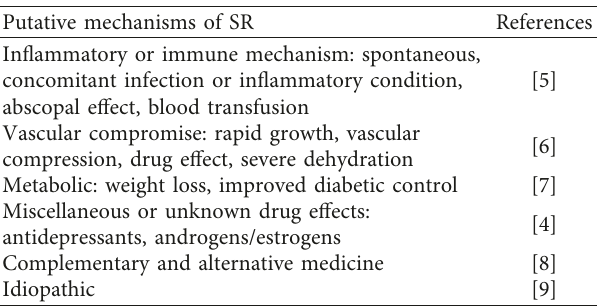
Table 1: Putative mechanisms of spontaneous regression of HCC reported in the